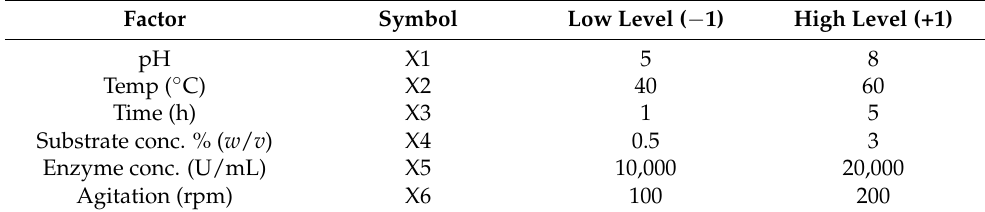
Table 2. Factors and testing levels for the Plackett–Burman experiment for saccharification of chicory root using inulinse enzyme produced from Rhizopus oryzae NRRL